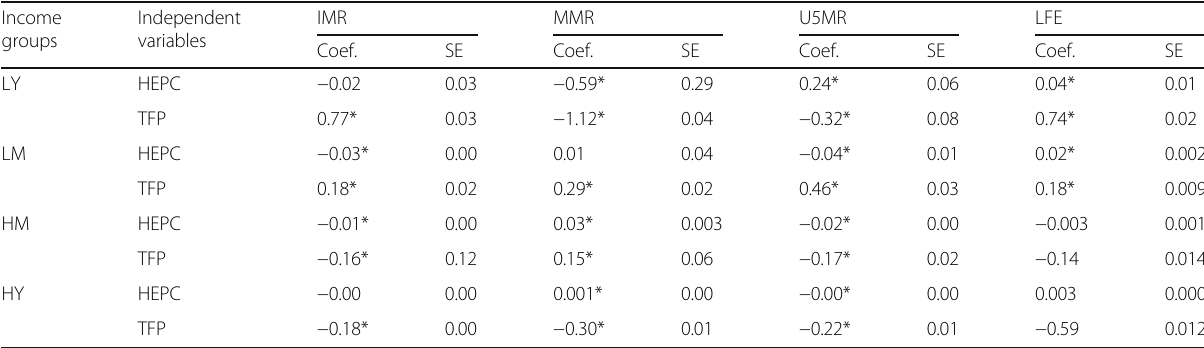
Table 9 Fully modified ordinary least squares test (with total factor productivity) Income groups